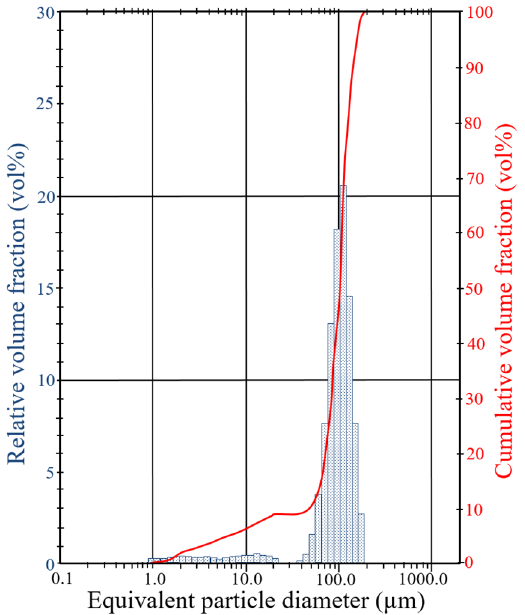
Figure 7. Particle size distribution in vol% of the calcined and treated Sra Ouertane (layer A1) phosphate rock.